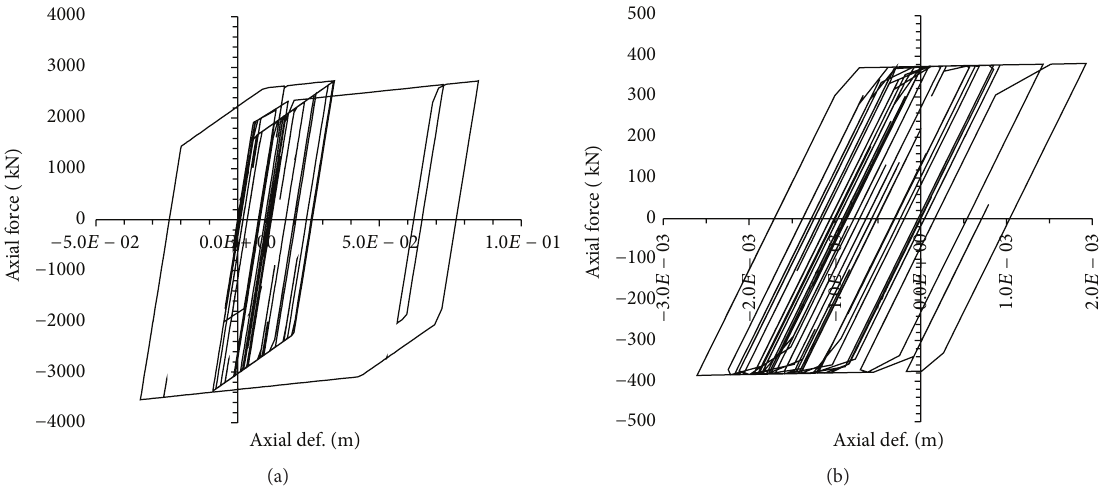
Figure 11: Typical cyclic response of BRBs obtained from the analysis. (a) Exterior brace; (b) interior